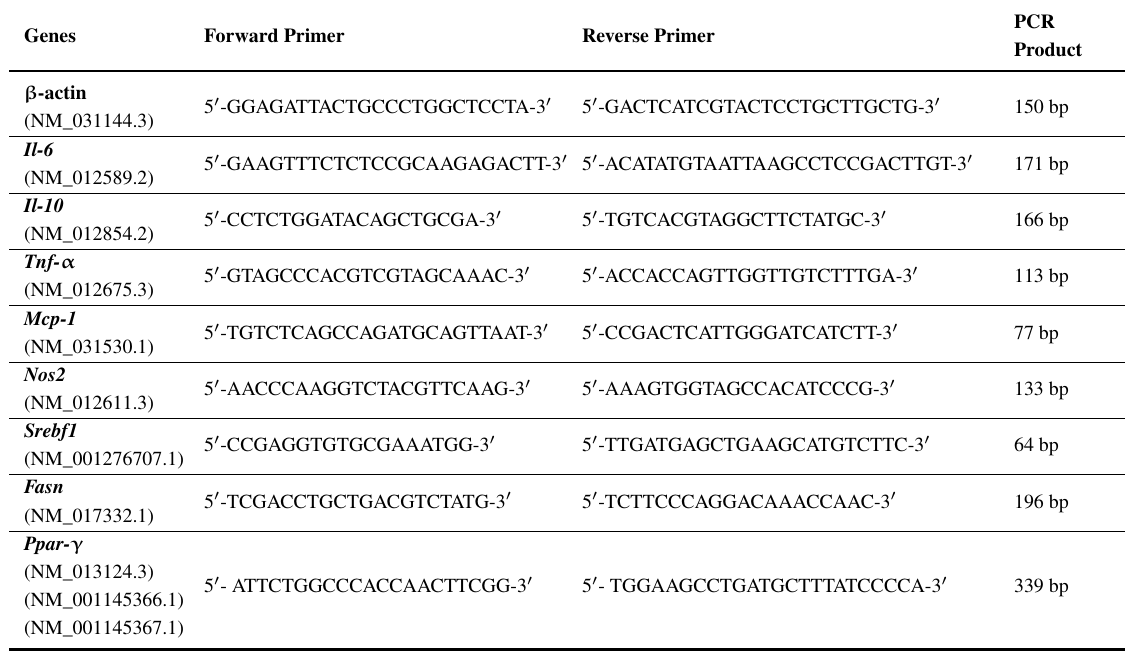
Table 2. Nucleotide sequences of primers used for PCR (Rattus norvegicus). Genes Forward Primer Reverse Primer